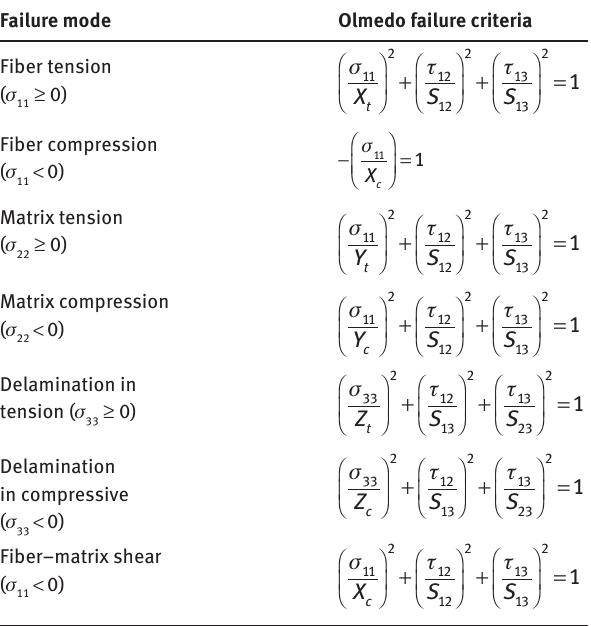
Table 3: The Olmedo failure criteria used in the